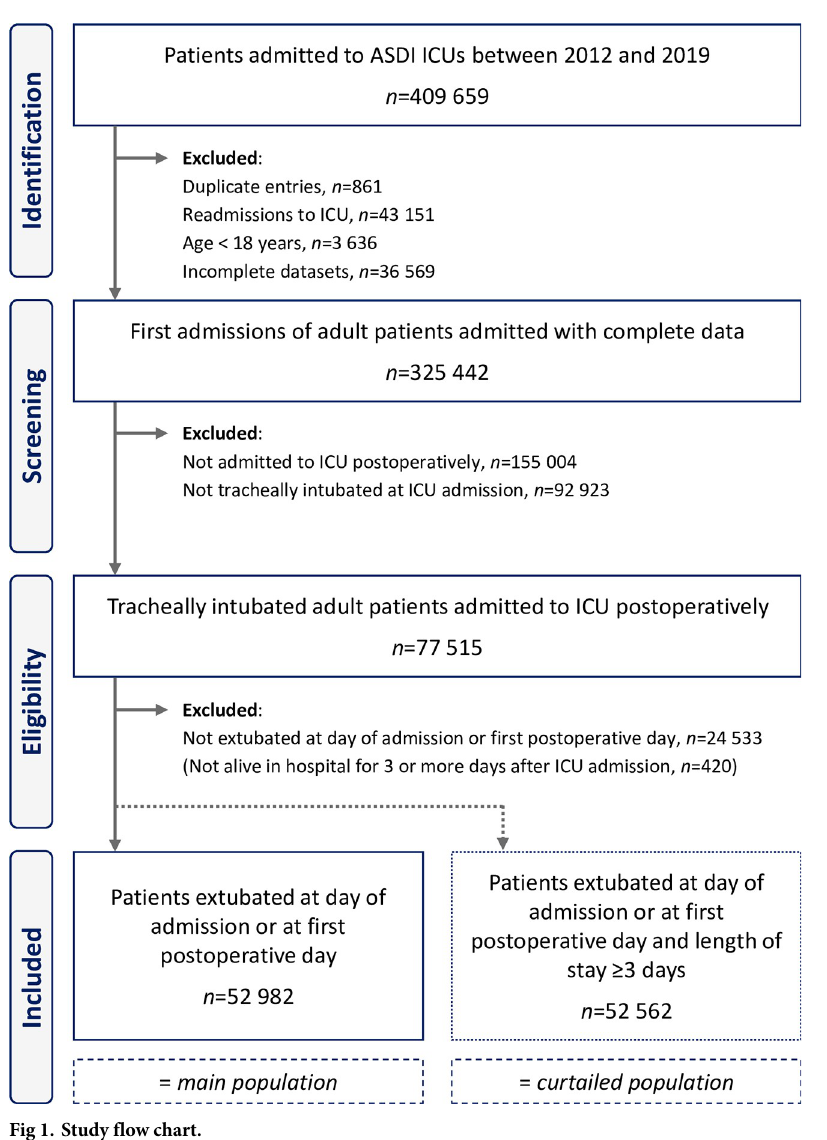
Fig 1. Study flow